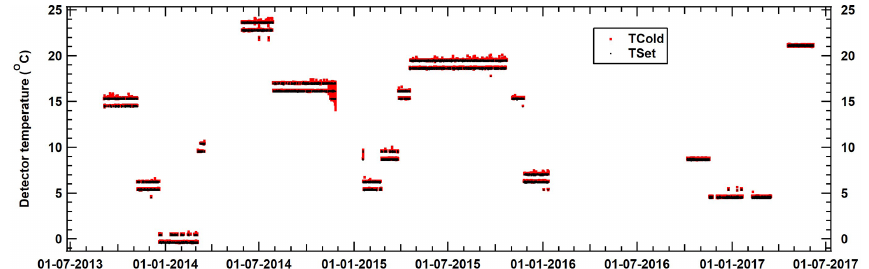
Figure F2. The time series of the nominal ( T set ) and the actual temperature ( T cold ) of the detector within the MAX-DOAS instrument.